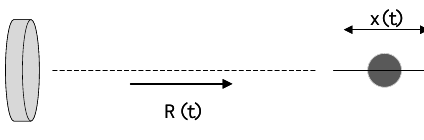
Figure 1. The micro-Doppler effect.